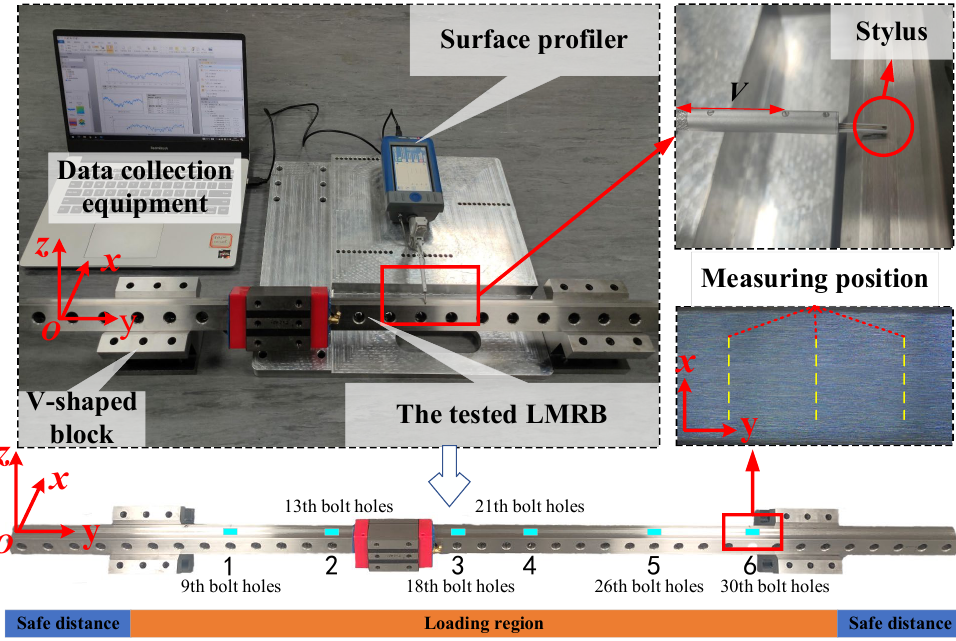
Figure 4. Device for measuring surface topography.